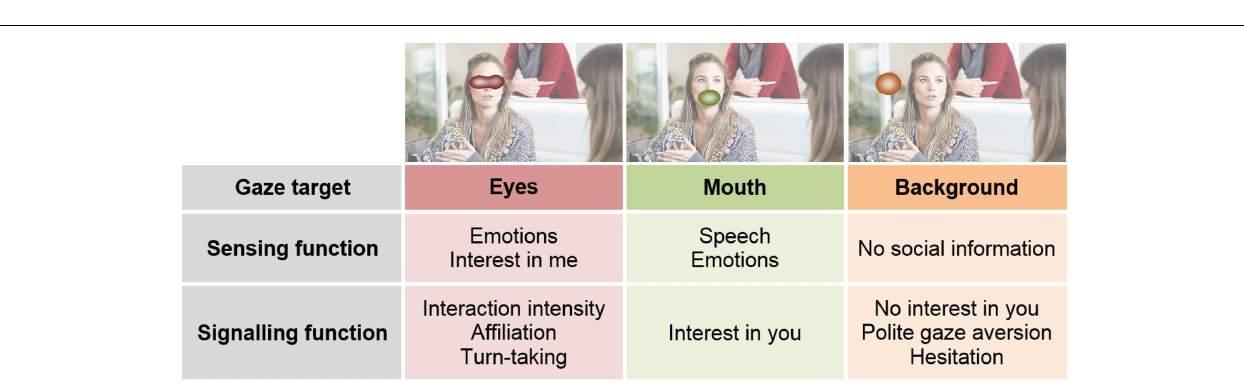
FIGURE 3 | The Interpersonal Gaze Processing model in a social scene. (A) Planning gaze when watching a video. (B) Planning gaze in a live interaction. Blurbs indicate areas of high saliency depending on the type of map. Original image published by Max Pixel under the Creative Commons CC0 License. Original maps were obtained with Saliency Toolbox for Matlab (Walther and Koch, 2006).